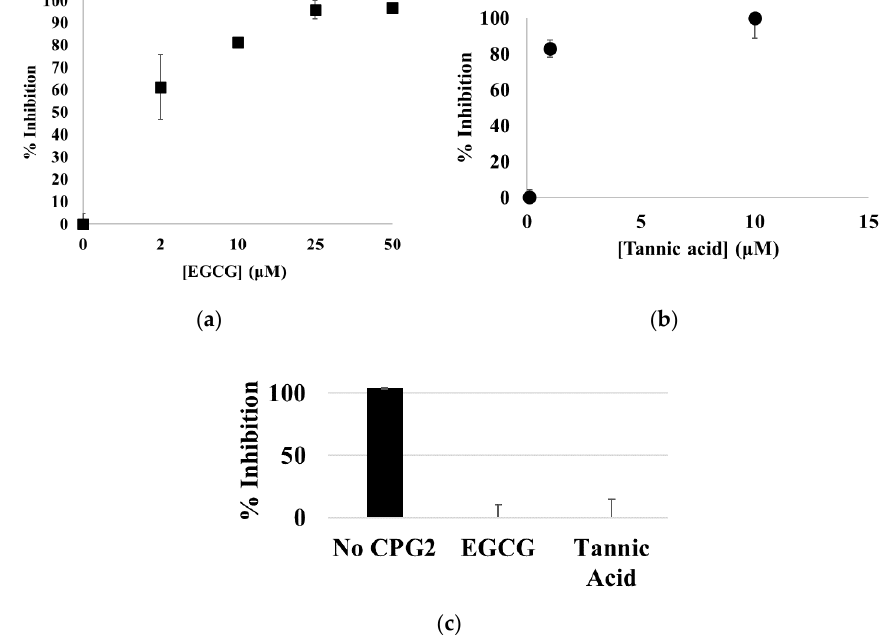
Figure 6. EGCG and tannic acid were analyzed at lower concentrations to determine their potency as T3SS inhibitors. ( a ) EGCG was screened at 50, 25, 10, 2, and 0 µ M. The IC 50 value of EGCG is 1.8 ± 0.4 µ M. ( b ) Tannic acid was screened at 10, 1, 0.1, and 0 µ M. The IC 50 value is 0.65 ± 0.09 µ M. ( c ) Neither EGCG nor tannic acid inhibits CPG2 directly at 50 µ